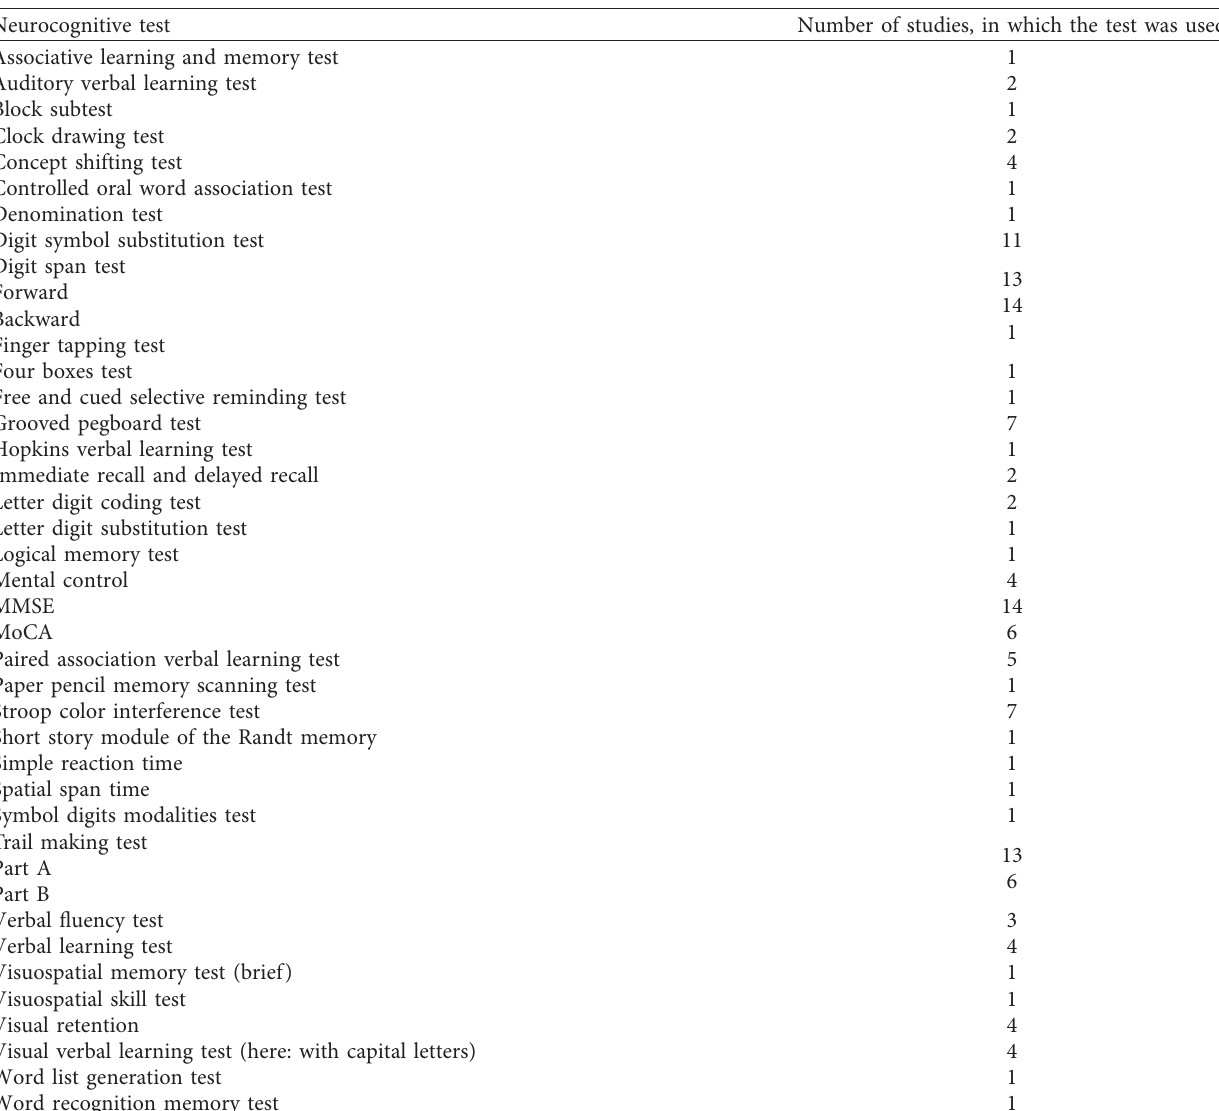
Table 2: Neurocognitive tests used in the included studies to define